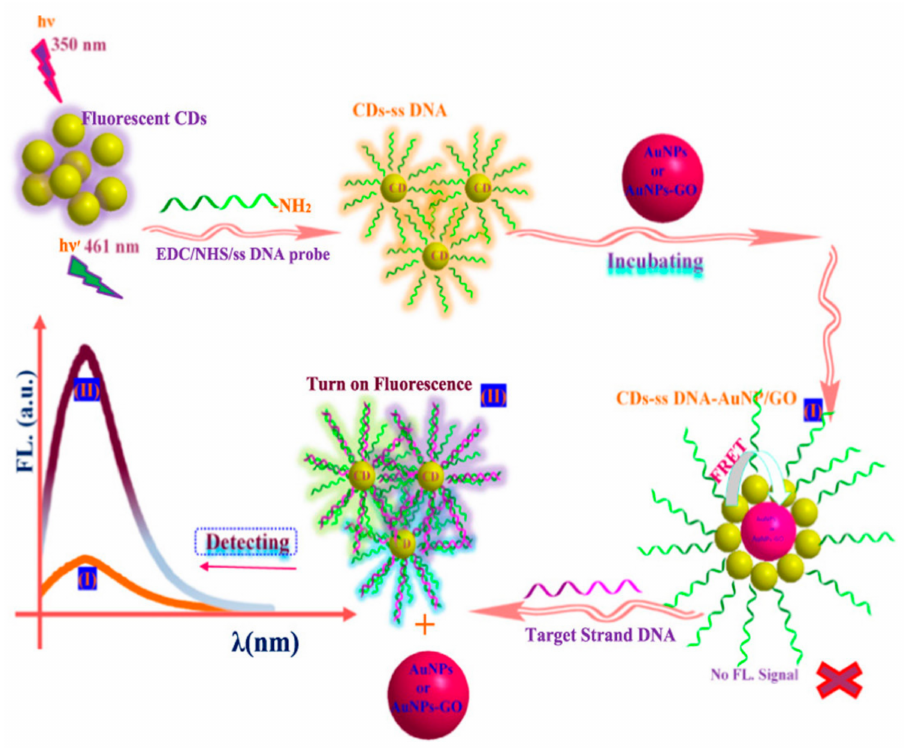
Figure 6. Schematic illustration of the fabrication of CQDs-ss DNA-AuNPs/GO for homogeneous HIV-1 gene detection at the femtomolar level. Reprinted with permission from Ref. [139]. Copyright 2017